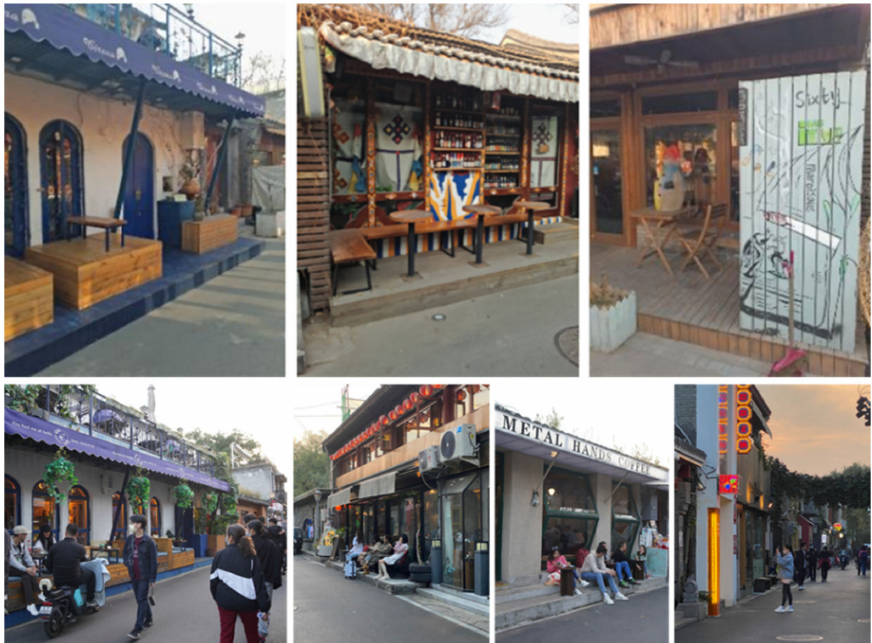
Figure 10. Typical transitional spaces between streets and buildings and tourists’ walking-stopping